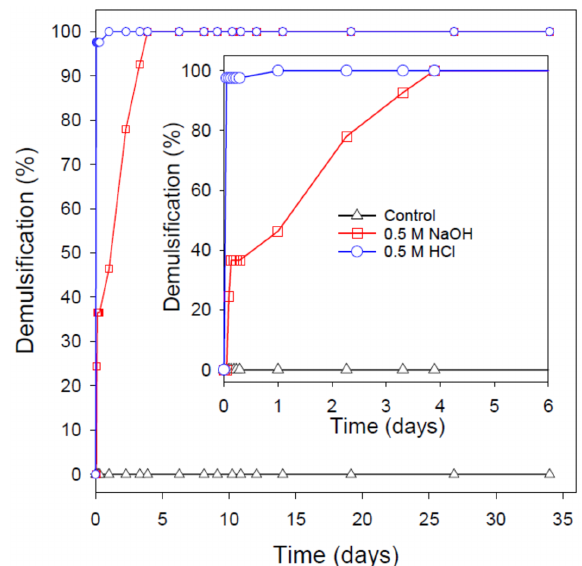
Figure 7. The long-term stability and demulsification process of the crude O/W nanoemulsion stabilized by 0.5 wt% SDBS using the pH-switching mechanism through the addition of 0.5 M HCl or NaOH. The demulsification process was conducted at ambient conditions and in the absence of any physical disturbances. The first 6 days of the demulsification process is shown in the inset.